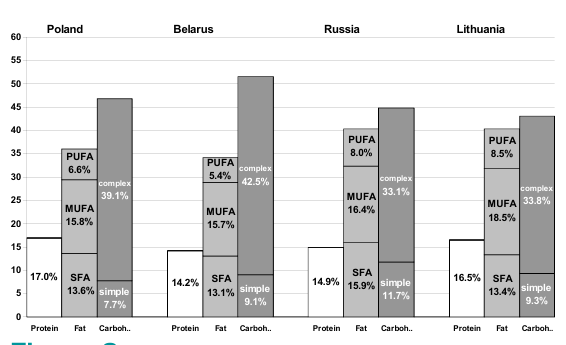
Figure 2. The percentage share of proteins, carbohydrates (simple and complex) , fatty acids (saturated fatty acids –SFA, monounsaturated fatty acids- MUFA, polyunsaturated fatty acids-PUFA) as energy sources in the Daily Nutrient Ratio ( DNR ) in female group.